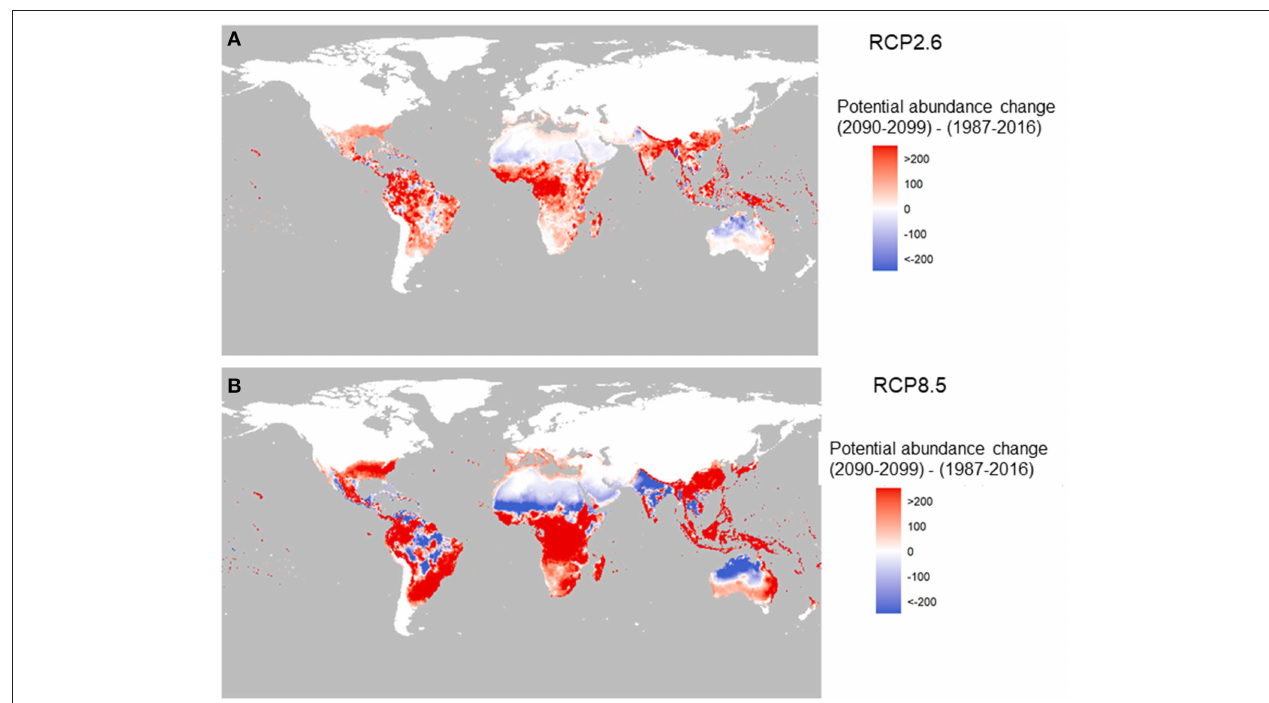
FIGURE 3 | Change in the potential abundance of Aedes aegypti (per larval site) over the twenty-first century (2090–2099 relative to 1987–2016). The two panels correspond to two carbon emission scenarios: RCP2.6 (A) and RCP8.5 (B) using Model A.